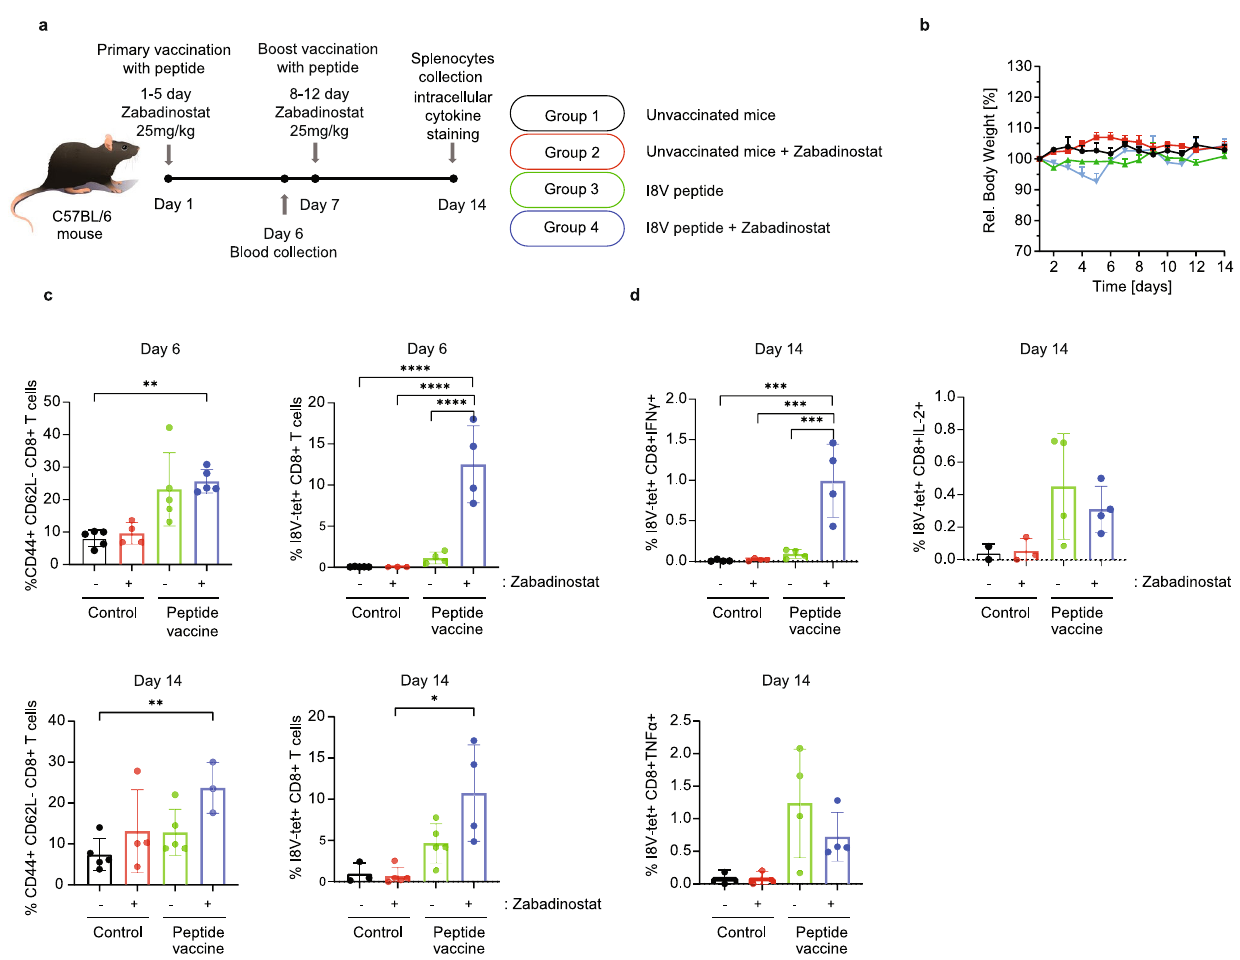
Fig. 4 Zabadinostat enhances the CD8 T-cell response. a Schematic representation of the immunogenicity experiment with zabadinostat and peptide vaccine. C57BL/6 mice were treated with orally administrated zabadinostat at 25 mg/kg for 14 days (5 days on/2 days off) and intravenous I8V peptide (days 1 and 7) with respect to vehicle-only control; n = 5 per group; b relative body weight representation of treated and non-treated mice; n = 5; c general effector memory T-cell activation (CD8 + CD44 + CD62L − positive T cells) at days 6 (in the blood) and 14 (in splenocytes), I8V-peptide-speci fi c CD8- positive T cells stained ex vivo with MHC tetramers at days 6 (in blood) and 14 (in splenocytes), and intracellular cytokine IFN γ , IL-2, TNF α secretion of I8V antigen-speci fi c CD8 T cells stained ex vivo with tetramers (day 14; in splenocytes) measurements by fl ow cytometry ( d ); n = 4 and n = 5; results presented as mean values + / − SD; one-way